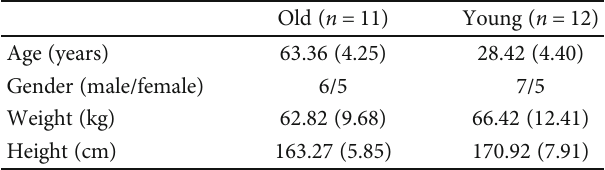
Table 1: Demographic data of the young and old healthy